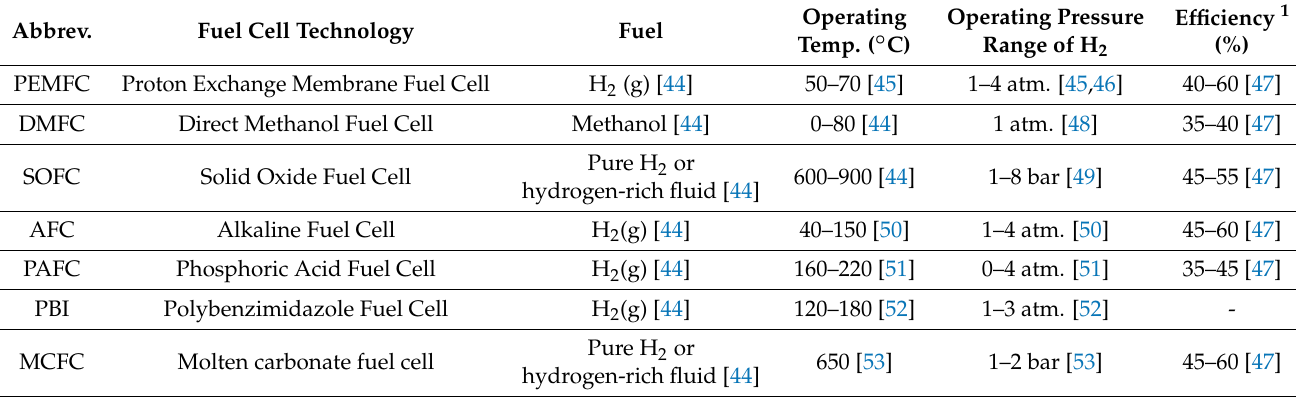
Table 2. Overview of fuel cell technologies with preferred fuels and operating conditions. Data from from references as specified in the table.